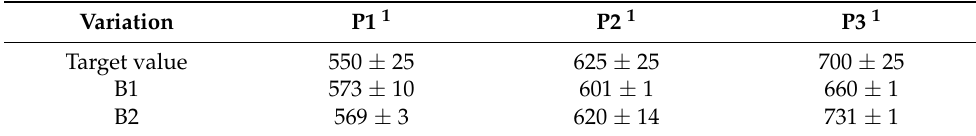
Table 1. Soluble nitrogen content of brewing malts ( n = 3). Variation P1 1 P2